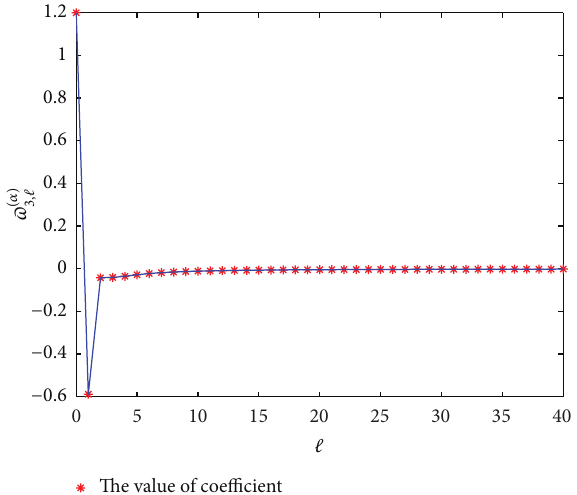
Figure1:Thevaluesofthecoefficients 𝜛 (𝛼) 3,ℓ (ℓ = 0, 1, . . .) for 𝛼 = 0.3